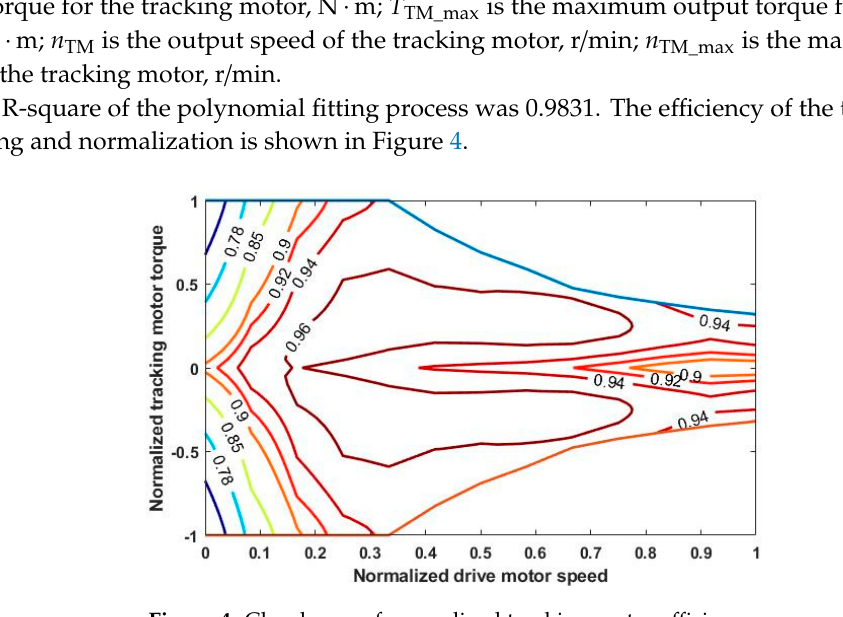
Figure 4. Cloud map of normalized tracking motor efficiency.